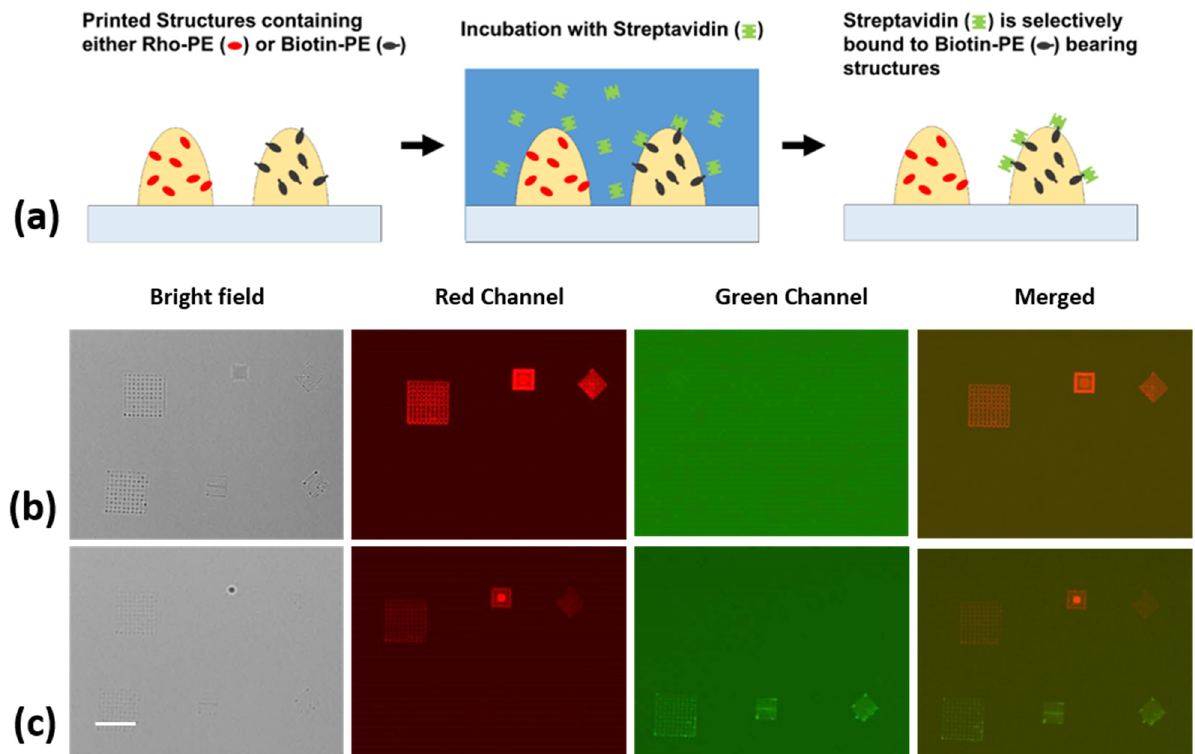
Figure 5. Biofunctionalization of adhesive-based structures by a model protein. ( a ) Scheme showing functionalization of the adhesive ink. Microscopy images of the ( b ) adhesive modified with rhodamine-PE (first row) and biotinylated adhesive structures (second row), and ( c ) the same adhesive structures after incubation with fluorescently labelled streptavidin, showing selective binding. Scale bar equals 40 µm for all images.